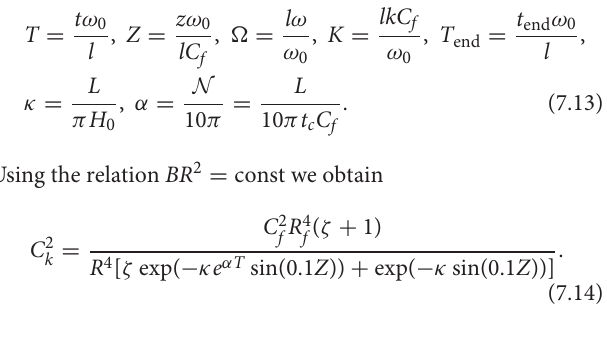
T end . The left panels correspond to λ FIGURE 3 | Dependence of the frequency on the distance along the loop for T = middle, and lower panels correspond to κ 0.5, κ 1, and κ 2, respectively. The solid, dashed, dotted, and dash-dotted curves correspond to N = = = N 0.2, N 0.1, and N 0, = = =